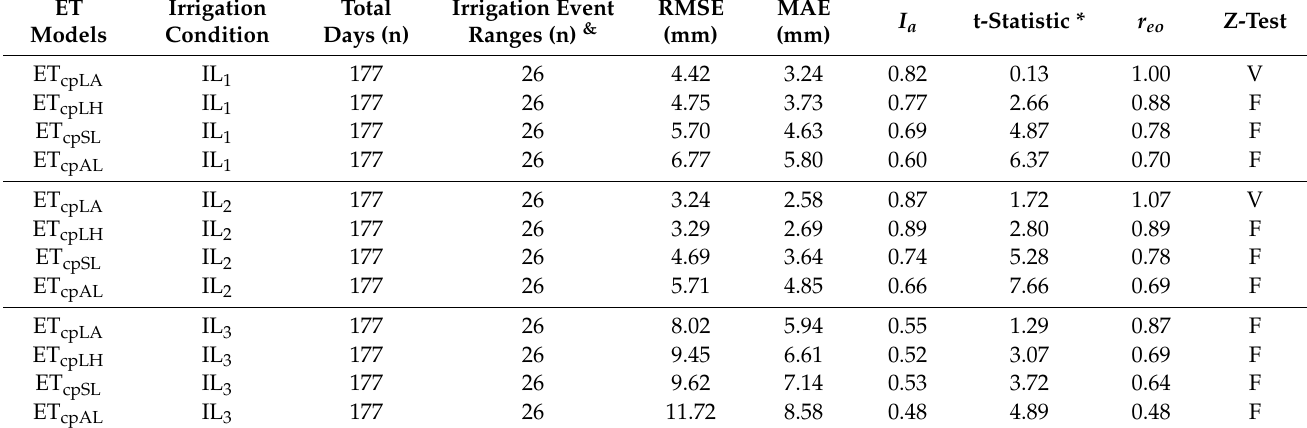
Table 2. Statistical evaluation of evapotranspiration over a potato crop estimated by the Penman– Monteith equation using four different canopy resistance models for both seasons (values of Figures